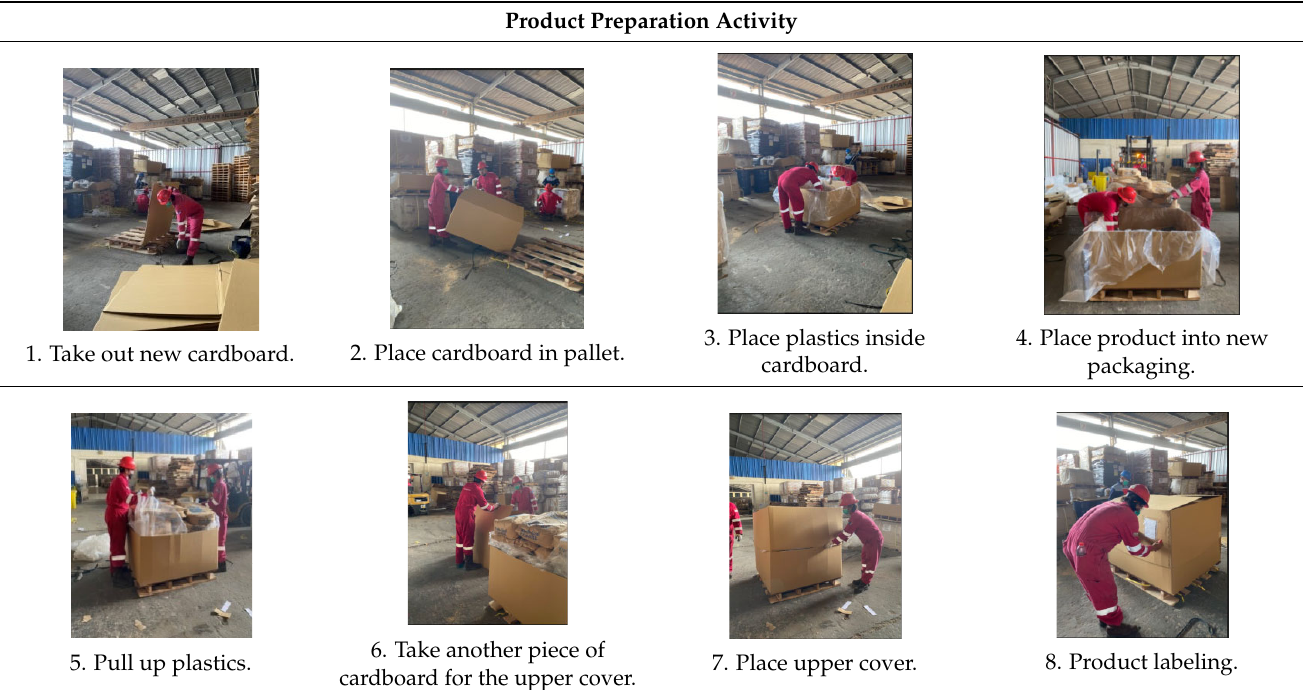
Table 4. Workers’ working positions. Product Preparation